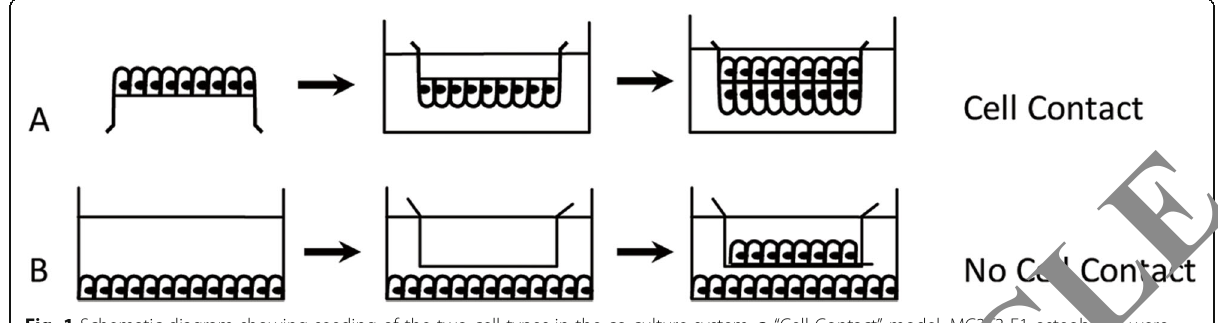
Fig. 1 Schematic diagram showing seeding of the two cell types in the co-culture system. a “ Cell Contact ” model: MC3T3-E1 osteoblasts were seeded on the basal surface of the membrane andMLO-Y4 osteocytes were then seeded on the apical surface of the membrane. The two cell types were permitted to come into direct contact. b “ No Cell Contact ” model: MC3T3-E1 osteoblasts were seeded on the bottom of the wells, and MLO-Y4 osteocytes were seeded on the apical surface of the membrane. The two cell types could not come into direct